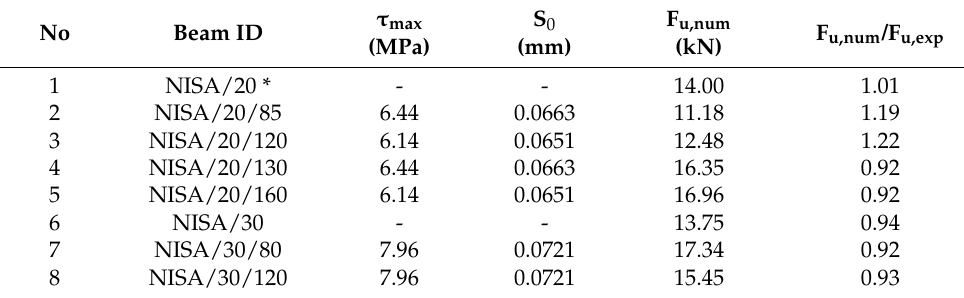
Table 5. Bond-slip properties and predicted load